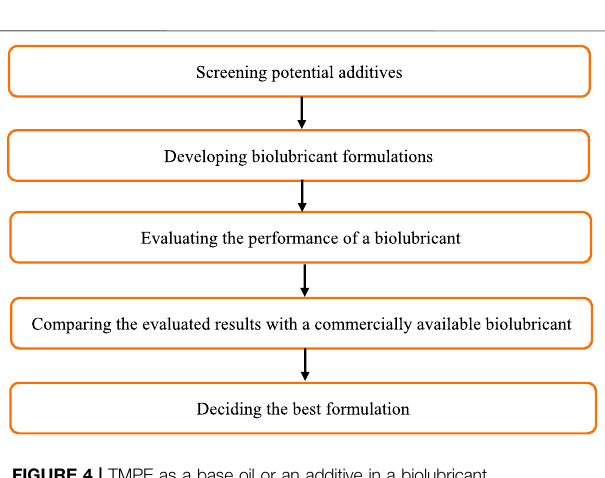
FIGURE 4 | TMPE as a base oil or an additive in a biolubricant formulation fl ow chart (Aziz et al.,